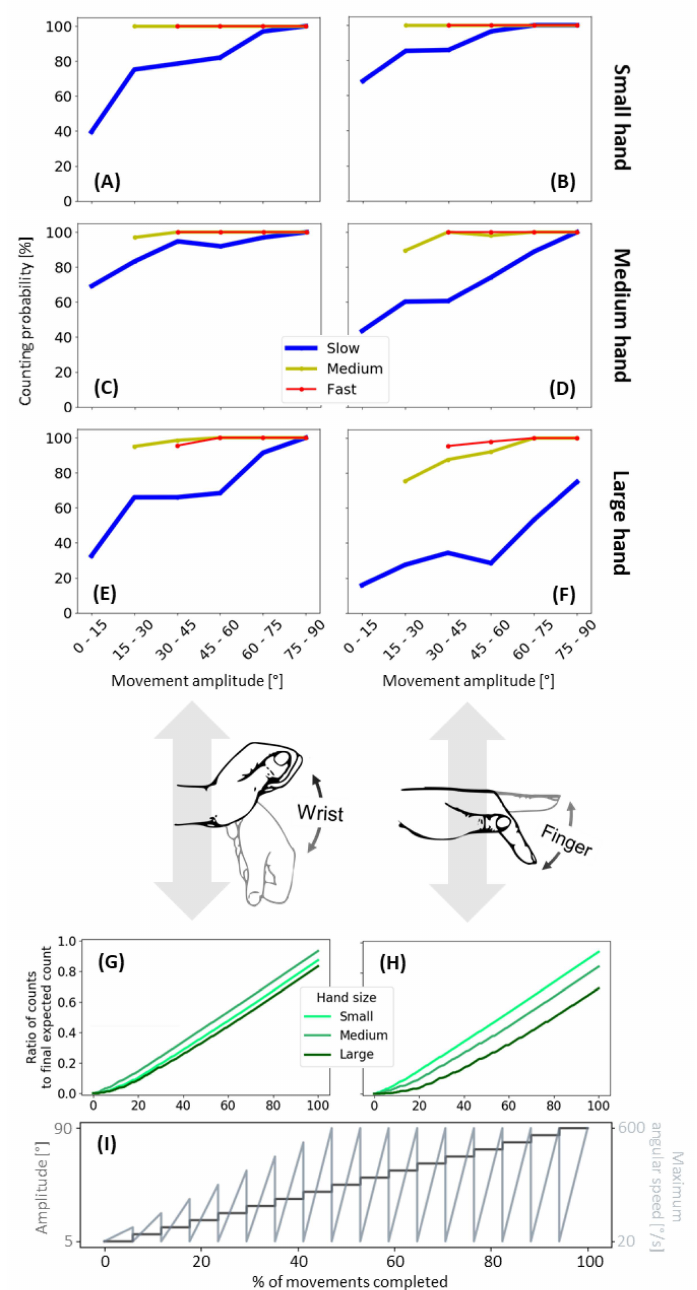
Figure 5. Results from the robotic simulation of wrist and finger movements. ( A–F ) Probability of counting emulated movements. ( top to bottom ) Shows probabilities for the three hand sizes: small, medium, and large; and ( right to left ) Shows probabilities for the emulated exercise types: wrist flexion and extension, and finger flexion and extension. For each hand size and exercise type, absolute maximum angular speed of the movement was used to classify it as slow, medium, and fast movement. The probabilities were calculated as the number of hand counts over the number of movements. ( G , H ) Show the number of counts over the total expected counts using emulated data for ( G ) wrist flexion and extension, and ( H ) finger flexion and extension. Bottom plot ( I ) shows the progression of the emulated movements that increased in amplitude over time sweeping through a range of speeds each amplitude. The range of speeds changes for the different amplitudes due to limitations on the maximum angular acceleration of the